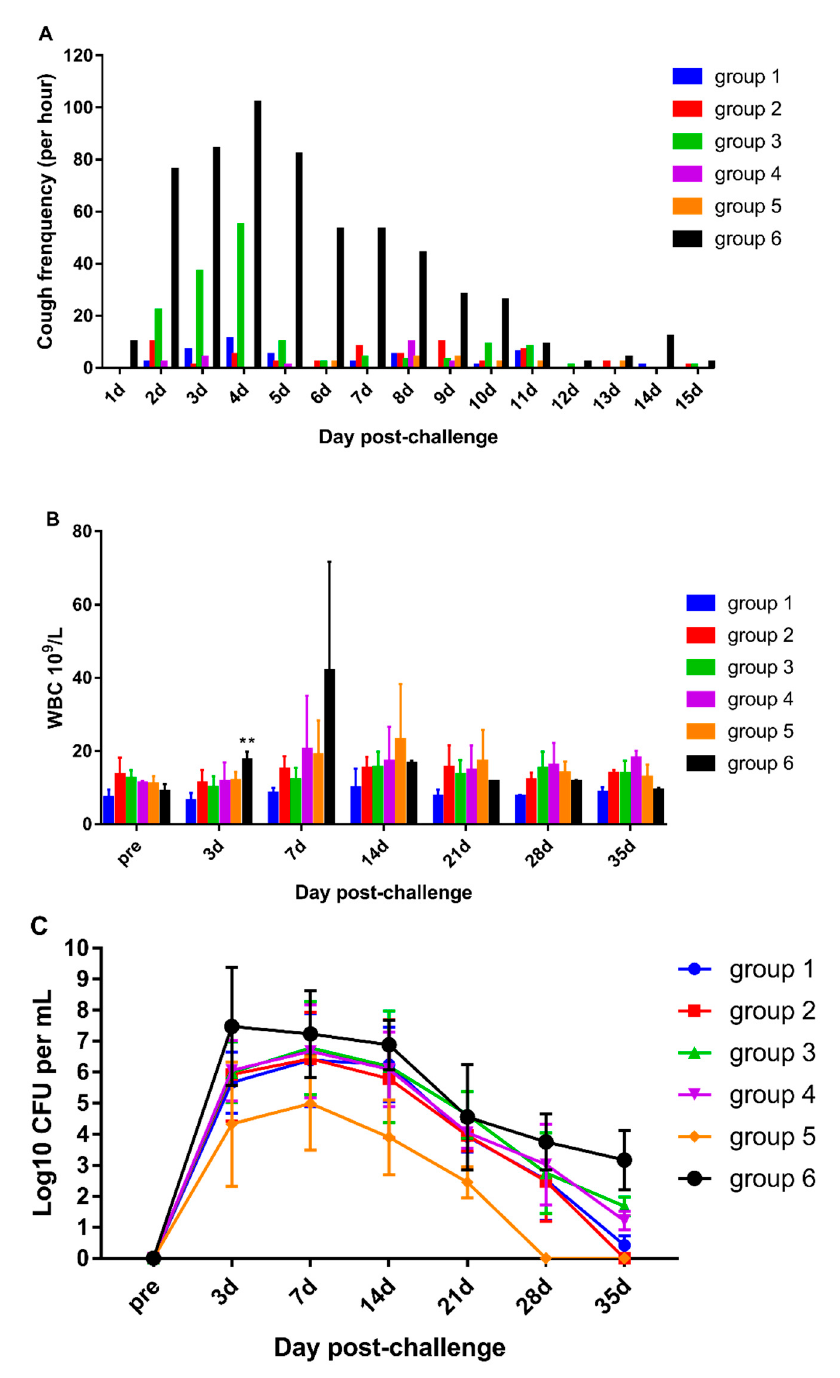
Figure 4. Cough count, leukocytosis, and B. pertussis colonization in rhesus macaques from different groups after B. Pertussis aerosol challenge. ( A ): Number of coughs after challenge, as recorded by audio equipment and calculated during three time periods each day (8:00–8:30, 12:00–12:30, 17:00–17:30). ( B ): White blood cell count of rhesus macaques after challenge. The number of circulating white blood cells before and after challenge was determined and compared by a blood cell counter, ** p < 0.01. ( C ): Colonization of the nasopharynx of rhesus macaques after challenge. Nasopharyngeal swabs were collected, and the recovered swabs were plated on B–G plates for 4 days for colonization. We measured the rectal temperature after the challenge and found no significant differences between all